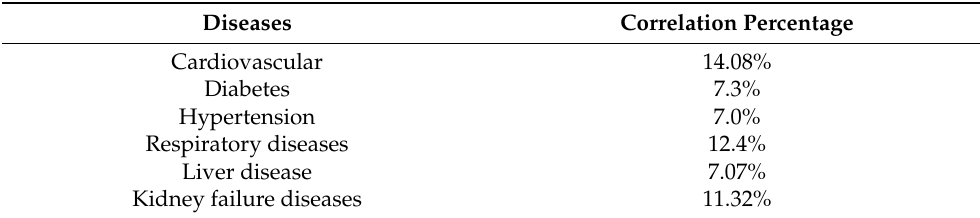
Table 6. Correlation between COVID-19 and medical